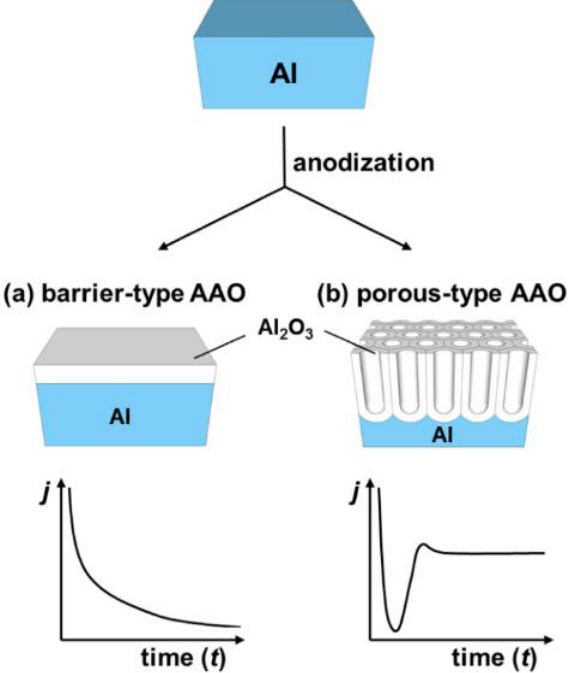
Figure 2. Types of anodic aluminum oxide and corresponding current-time transients. ( a ) Barrier type and ( b ) porous type. Reprinted with permission from [49]. Copyright 2014 American Chemical